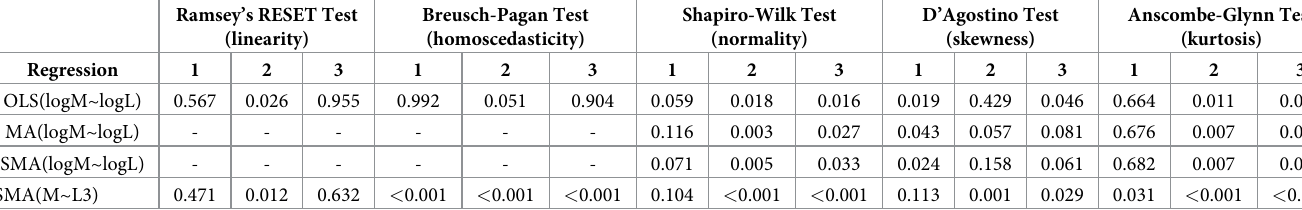
Table 4. Tests of the assumptions of regression-based body condition indices for different size class groups. Size groups were defined based on the fitted segmented regression model (Fig 2), which defined size groups as hatchlings to early juveniles (group 1, < 20.2 cm SVL), late juveniles to reproductive-sized adults (group 2, 20.2 cm to 30.0 cm SVL) and large adults (group 3, > 30.0 cm SVL). We tested three assumptions, whether 1) data are linear, 2) variance is constant (i.e., homoscedastic), and 3) frequency distribution of residuals is normal. Only p-values are